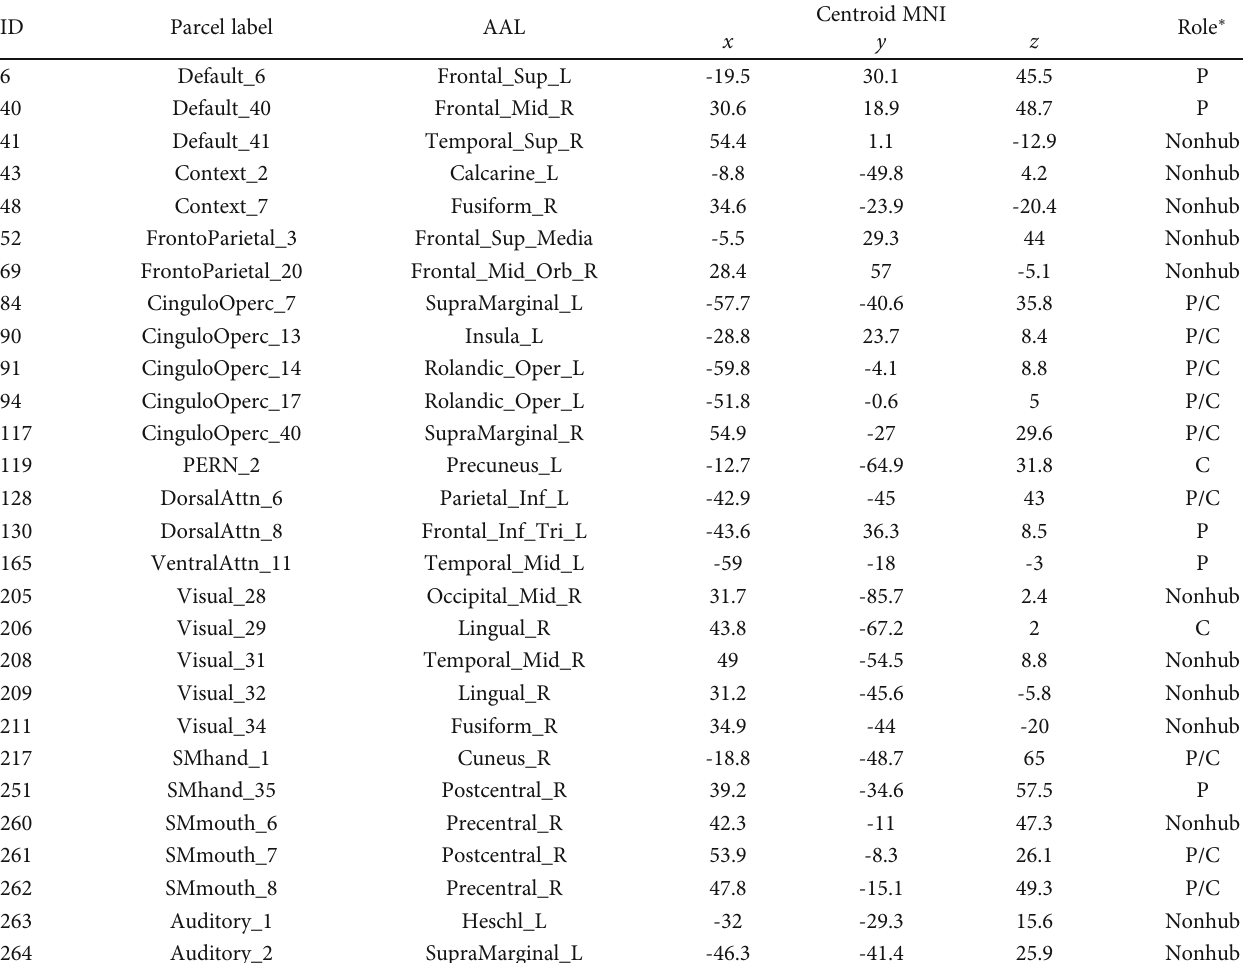
Table 1: The nodes of connected network in the emotion and working-memory versus the resting-state condition during the network-based statistical